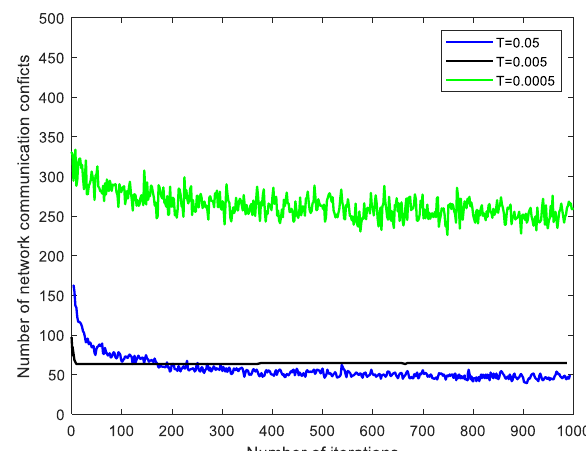
Figure 12. Effects of different T 0 on signal conflict.